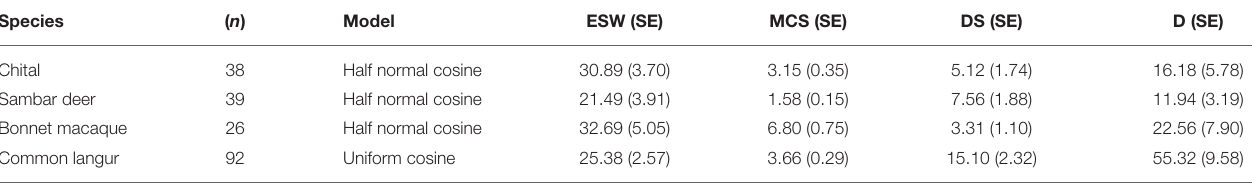
TABLE 3 | Individual and group densities of major wild prey species of leopards estimated in Sanjay Gandhi National Park, Mumbai, Maharashtra in 2015. Species